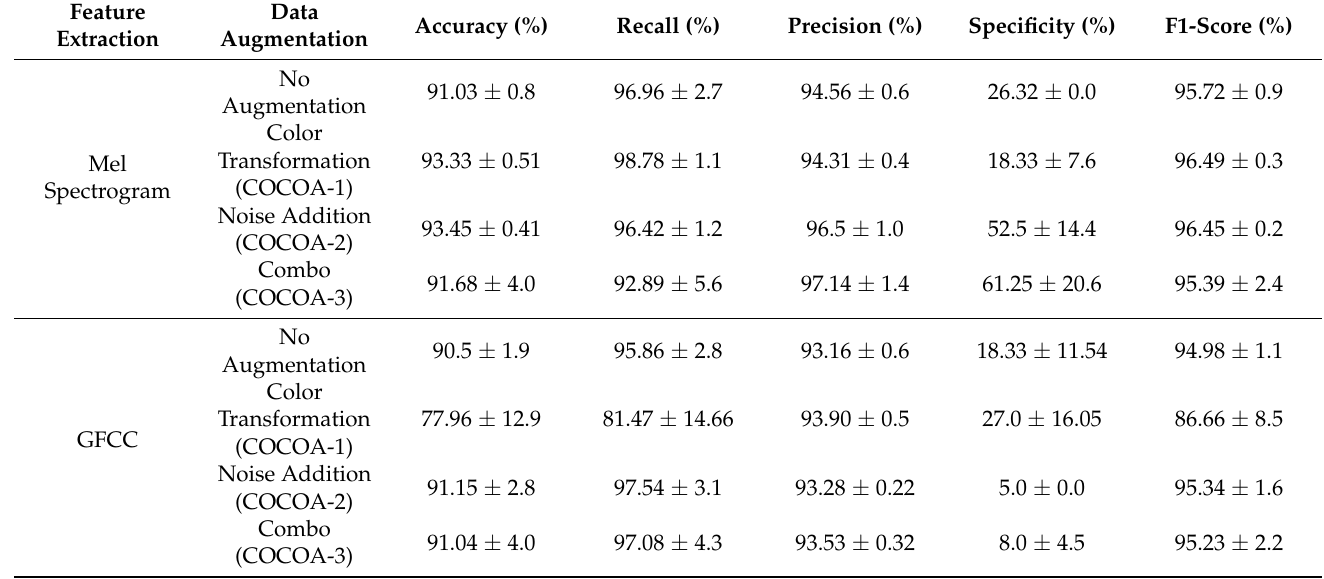
Table 9. Results Analysis of Positive COVID-19 vs. Healthy on applied feature extraction